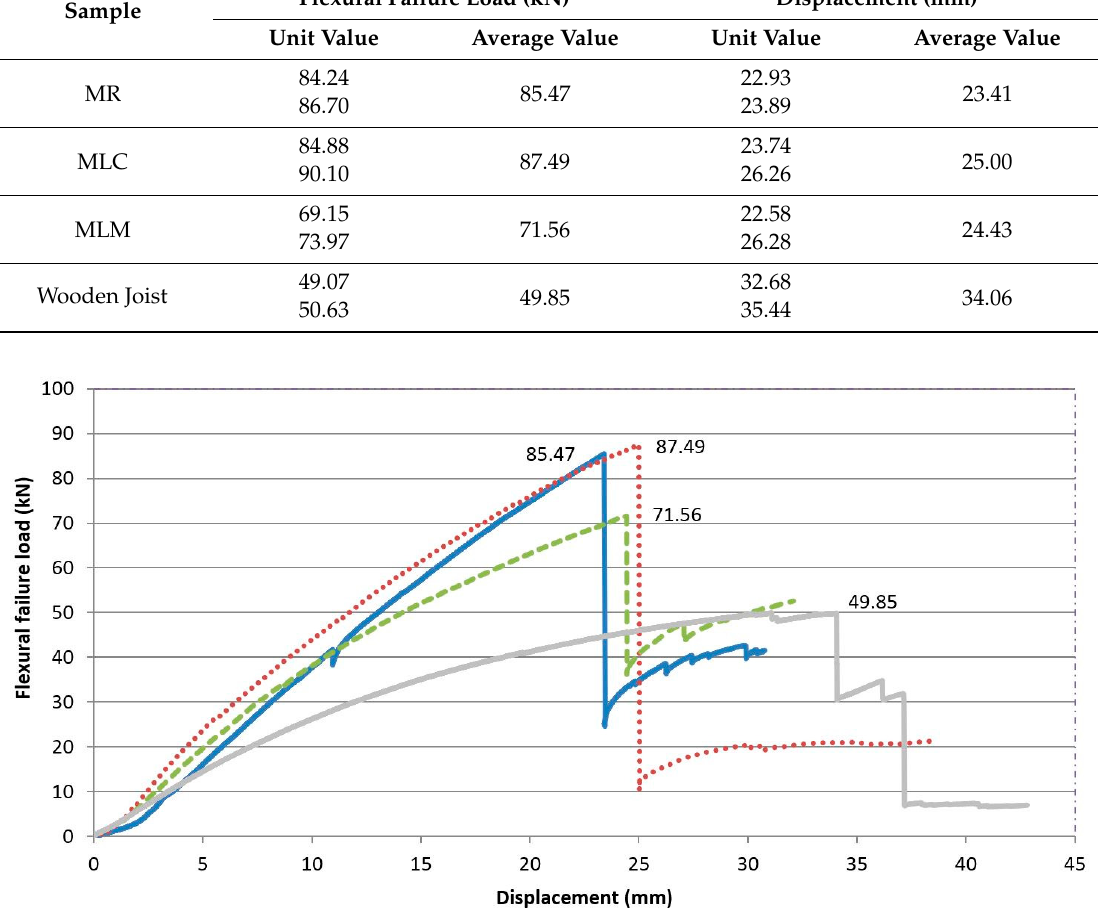
Figure 14. Full-scale test results.